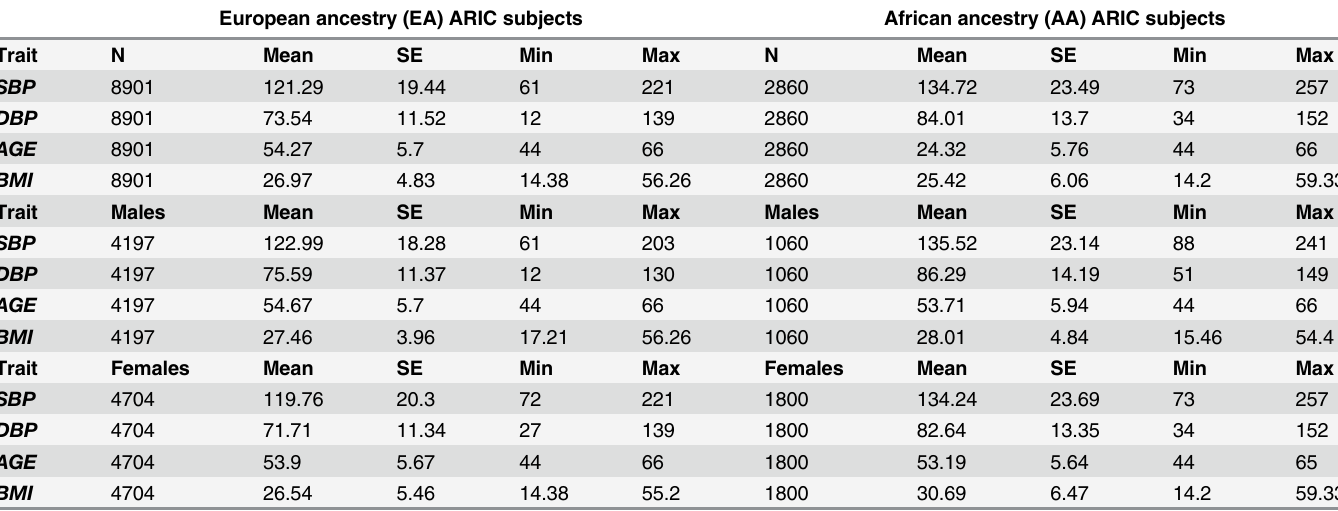
Table 1. Summary statistics of ARIC European ancestry (EA) and African Ancestry (AA) subjects used. European ancestry (EA) ARIC